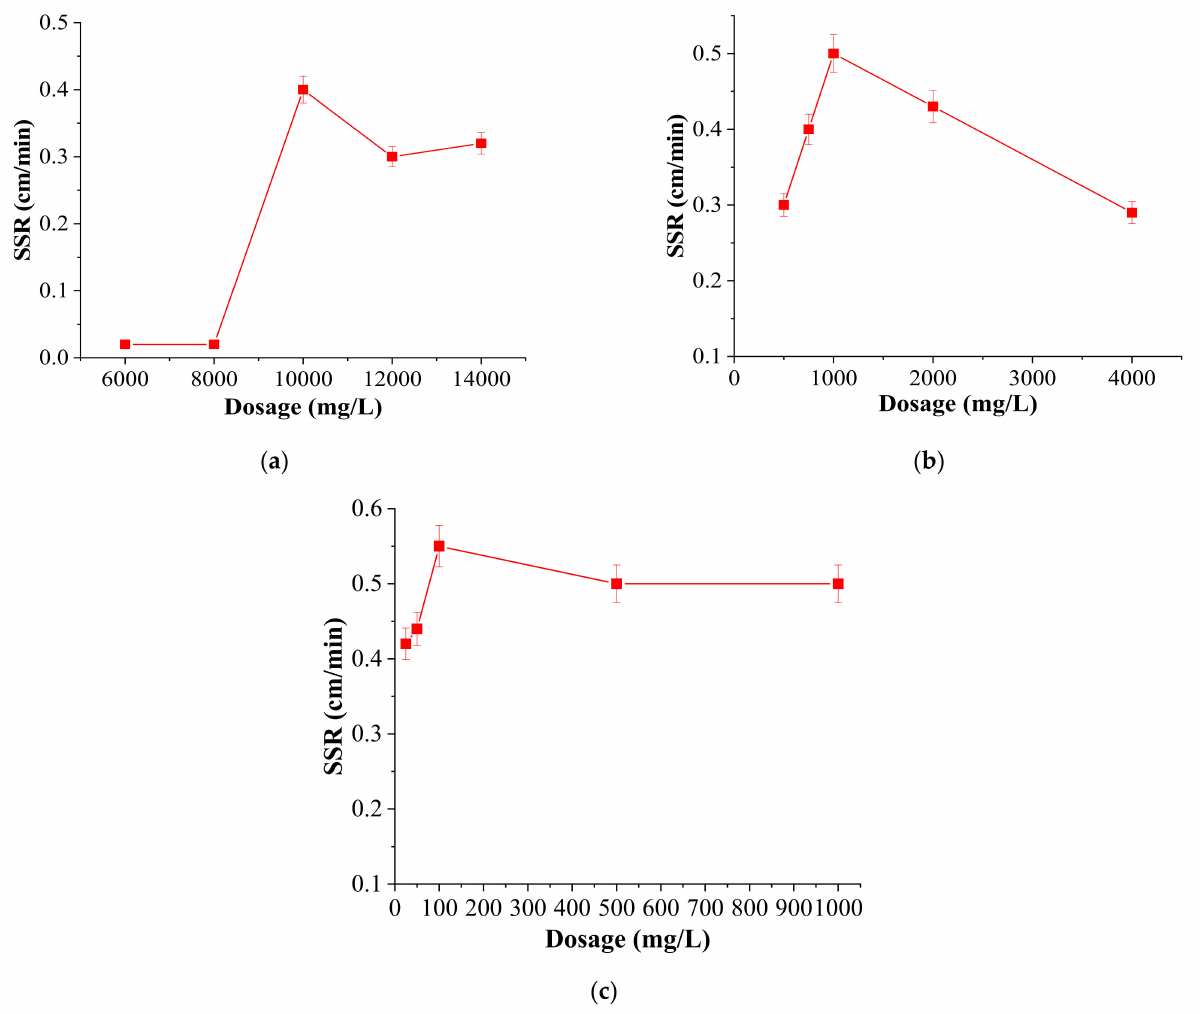
Figure 7. Sludge settling rate (SSR) of ( a ) 10,000 mg/L SnCl 4 ; ( b ) SnCl 4 8000 mg/L + RS 1000 mg/L; ( c ) SnCl 4 6000 mg/L + PAM 100 mg/L, at pH